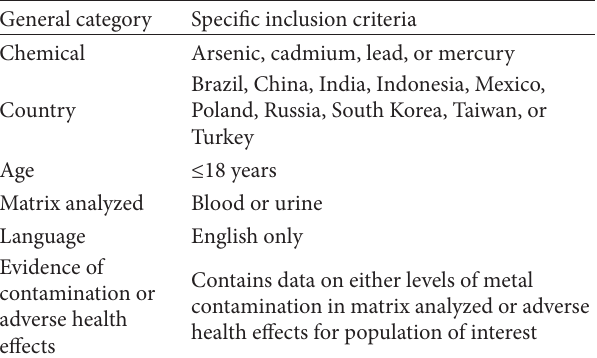
T 1: Criteria for inclusion of journal